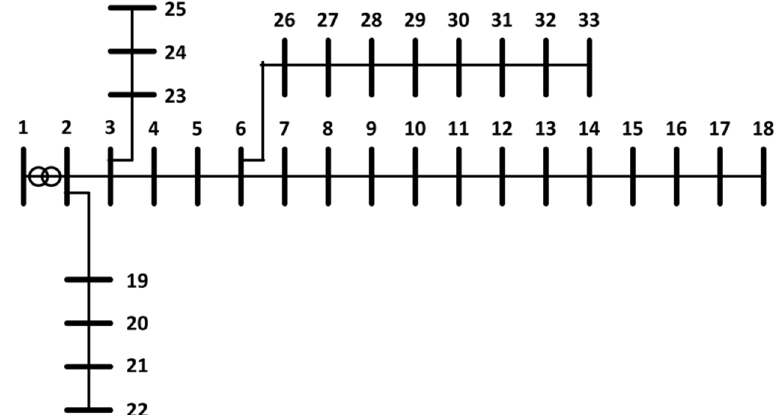
Figure 5. IEEE 33-bus standard distribution system.